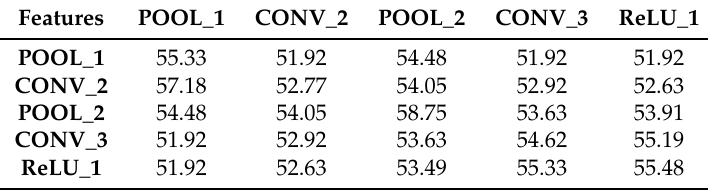
Table 5. Generalization performance of ELM-CNN features fusion on VAIS